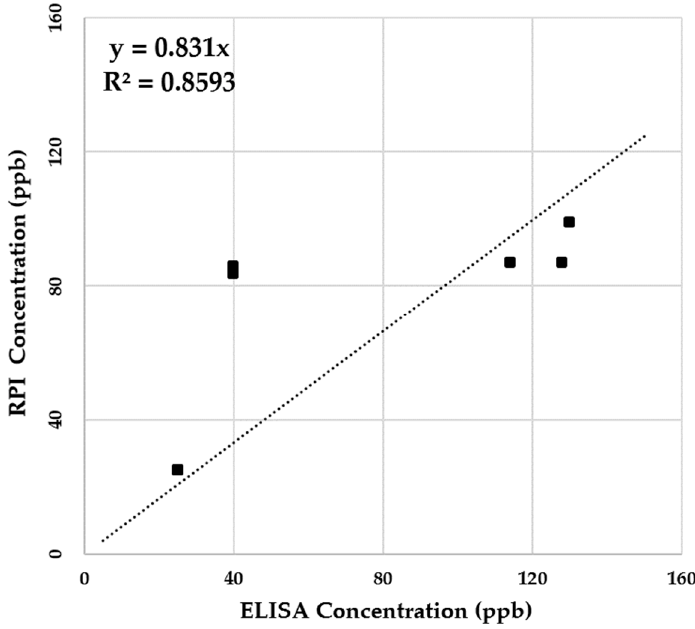
Figure 6. T-2/HT-2 quantification (expressed in ppb) in 9 field grain samples with the two different screening approaches, i.e., ELISA test and PRX assay.